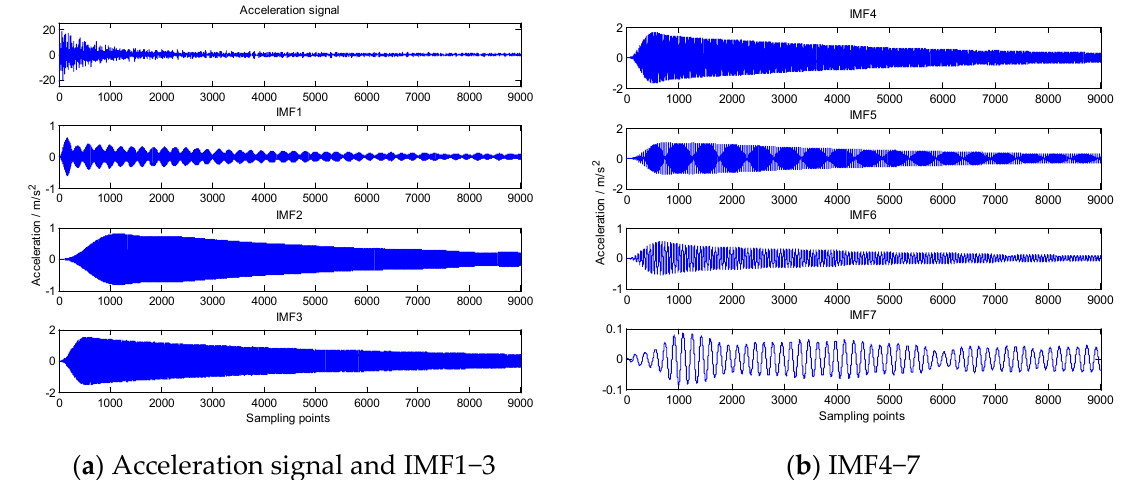
Figure 11. Acceleration signal and IMF1−7 using IEMD.